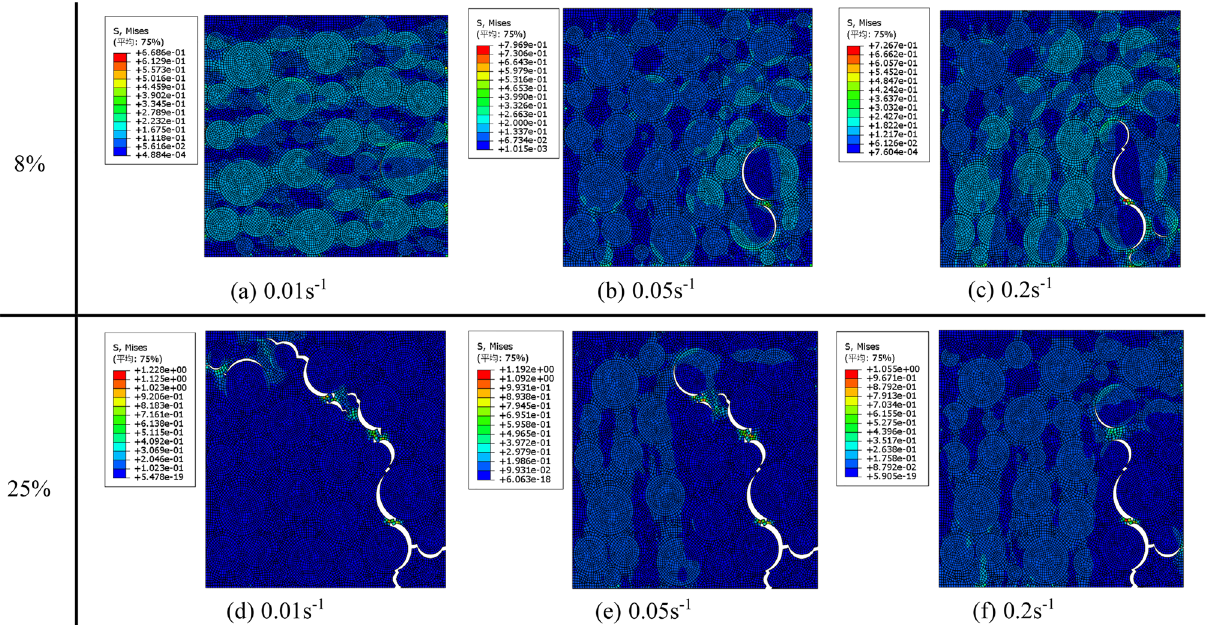
Figure 19. Stress nephograms of different strain rates at 8% and 25% strain under 1:2 biaxial tensile